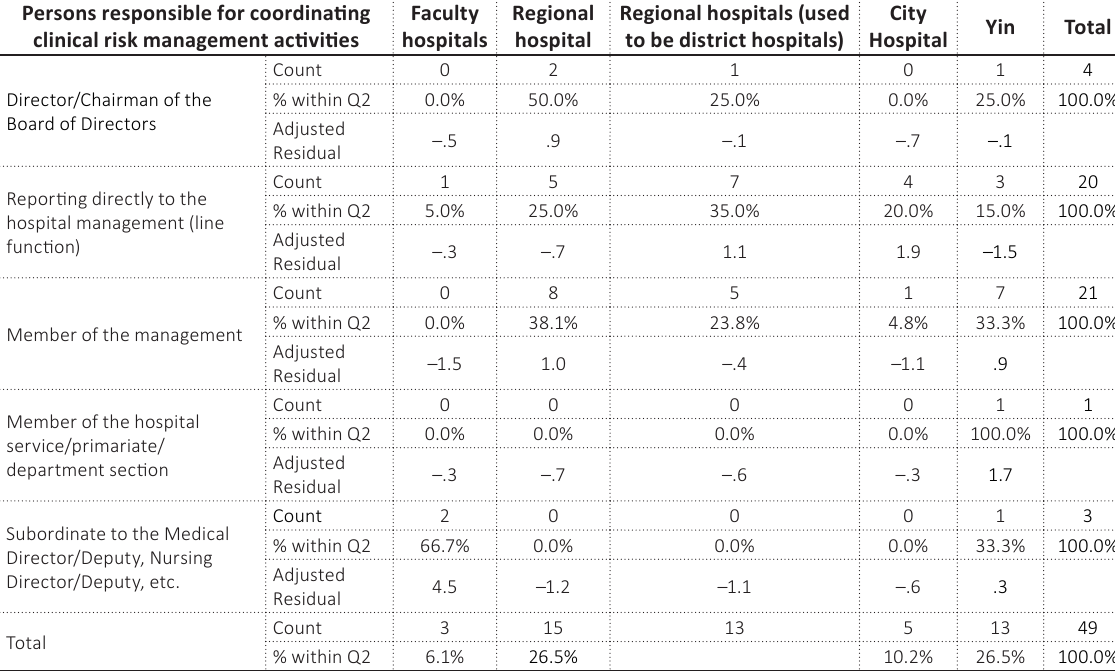
Table 5. Positions of persons responsible for coordinating clinical risk management activities in individual types of hospitals